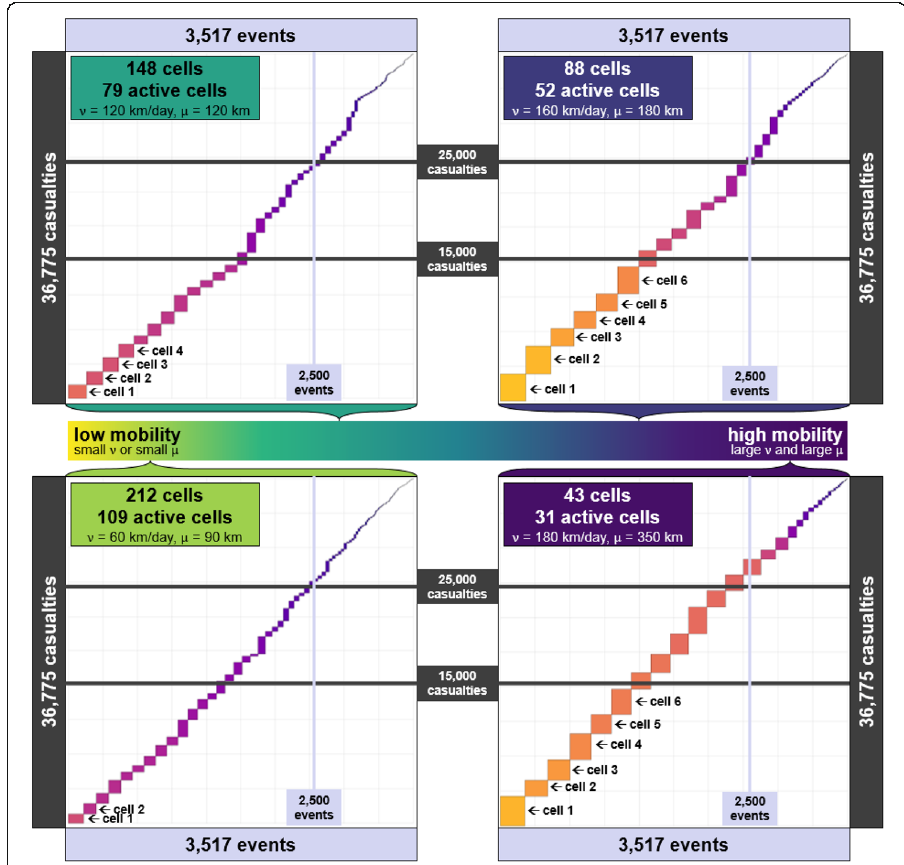
Fig. 11 Four sections of the parameter space showing the cumulative number of events (horizontal axis) and the cumulative number of casualties (vertical axis) of the cells, sorted in decreasing order, from the cell with the highest number of events to the cell with the lowest number of